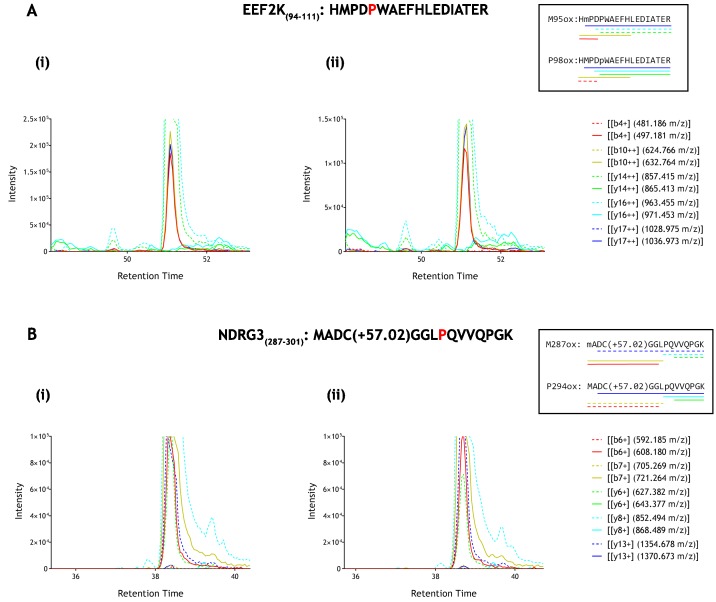
Parallel reaction monitoring (PRM) of oxidised EEF2K(94-111) and NDRG3(287–301) peptide species by mass spectrometry.Fragment ions (n = 5), including ions of discriminatory mass for proline and methionine oxidation (see inset for schematic representation of fragment ions; dashed lines: unoxidised, solid lines: oxidised) were selected for PRM acquisition, based on existing MSMS data (Supplementary file 1: A167-169 and A207-209). The figure shows XIC data of PRM fragment ions corresponding to oxidised forms of (A) EEF2K(94-111) and (B) NDRG3(287–301) derived from IVTT hydroxylation assays under (i) control or (ii) PHD2-reacted conditions. Fragment ion masses indicative of proline oxidation were not observed across the elution profile. Note, the y-axis has been truncated to show fragment ions of lesser abundance (peak maxima for panels A and B: >1×106 ion counts).